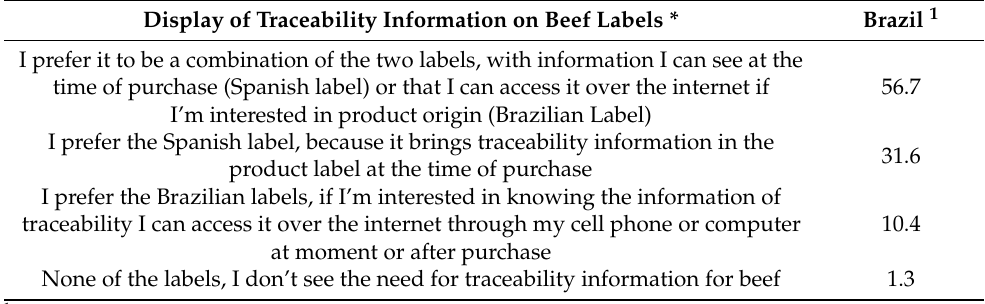
Table 8. Brazilian consumers’ preference according to the amount of information on the beef